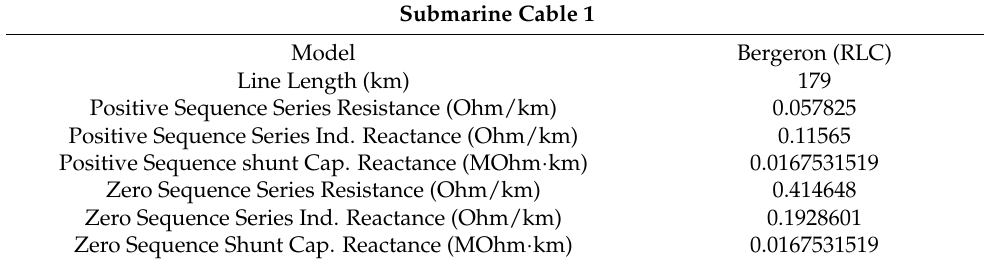
Table 13. Data of Submarine Cable 1.